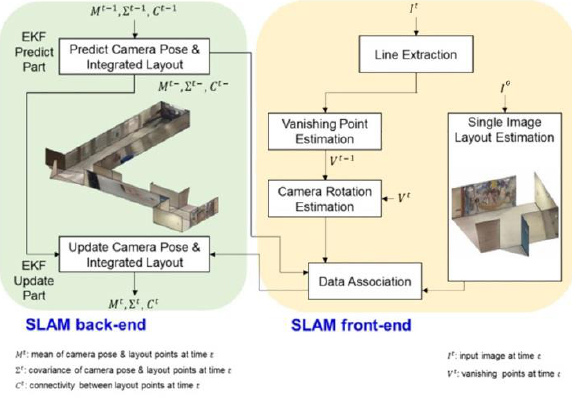
Figure 3. The workflow of the proposed